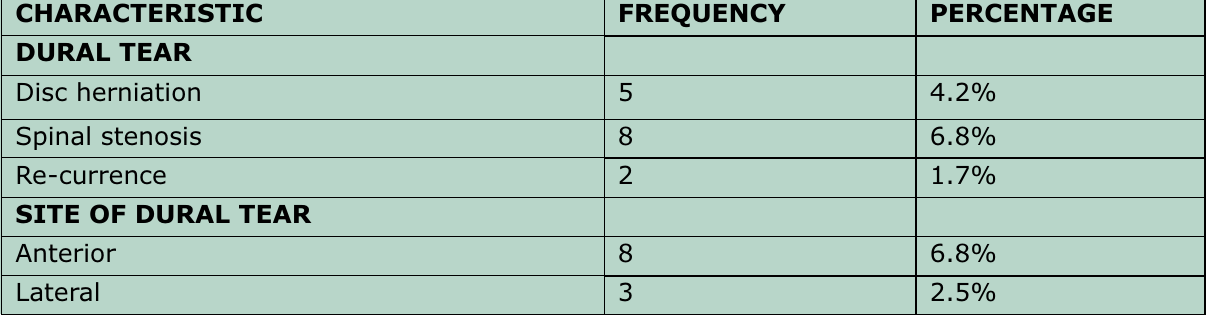
Table-III. D  ural tear and